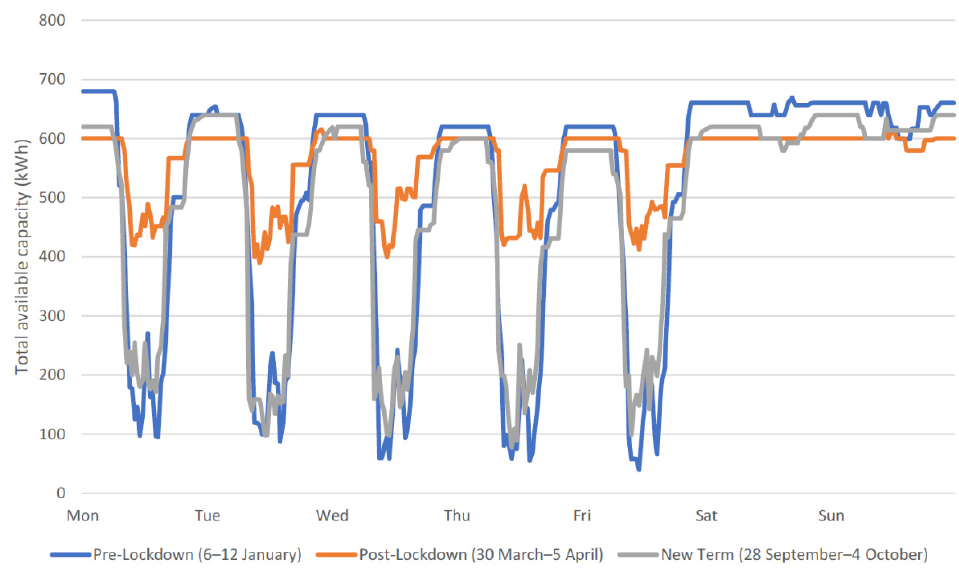
Figure 6. Comparison of example weekly available capacity profiles in 2020 from the pre-lockdown, post-lockdown, and new term phases.